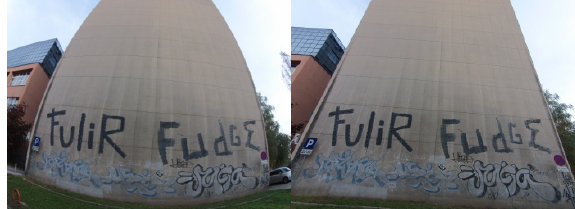
Figure 4. Image 542: left - original, right - with the initially removed distortion